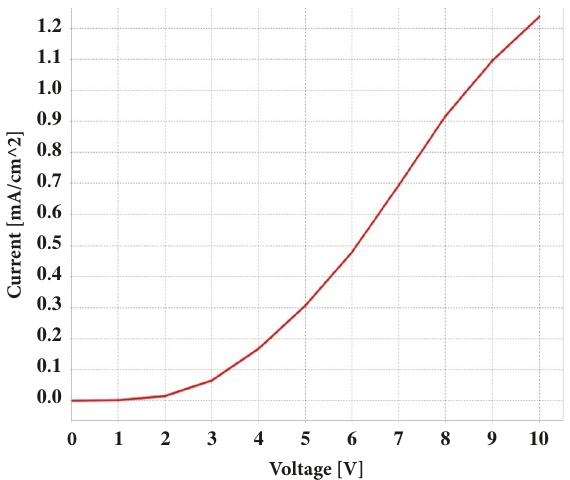
Figure 15: JV plot of of device B1.